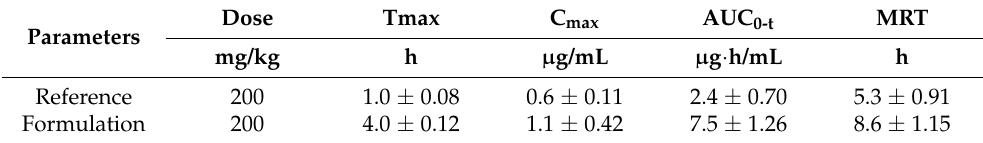
Table 5. Pharmacokinetic parameters.